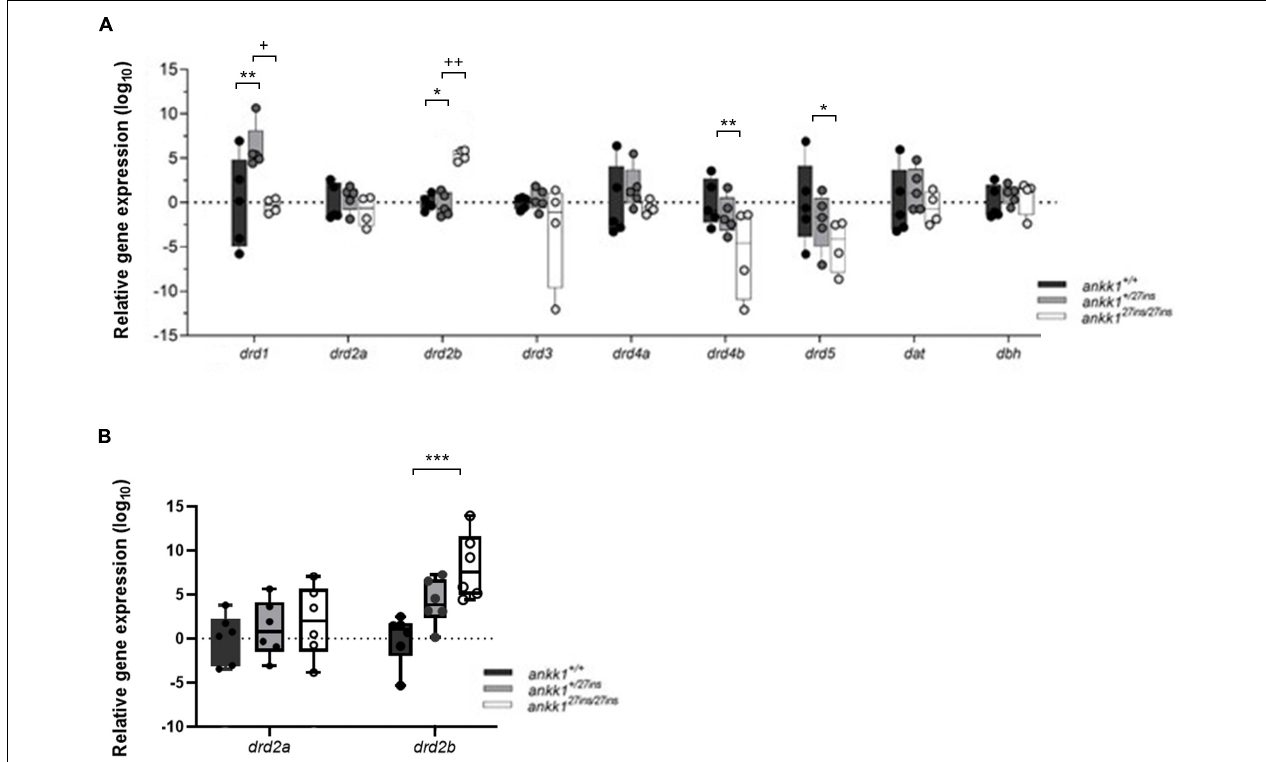
FIGURE 5 | Quantification of dopaminergic gene expression. (A) Expression levels of drd2a , drd2b , drd1 , drd3 , drd4a , drd4b , drd5 , dat , and dbh in 5 days post fertilization zebrafish larvae ( ankk1 + / + , ankk1 + / 27 ins , and ankk1 27 ins / 27 ins ) measured by qPCR. Each dot represents a pool of larvae ( n total = 80 larvae: 5 samples consisting of 16 larvae for ankk1 + / + and ankk1 + / 27 ins , and 4 samples consisting of 16 larvae for each sample (ankk1 27 ins / 27 ins ). (B) Expression levels of drd2a and drd2b in adult zebrafish whole brains. Each dot represents a single brain. Data are shown in box-whiskers plot (5–95 percentile). Legend: * p < 0.05 versus ankk1 + / + ; ** p < 0.01 versus ankk1 + / + ; *** p < 0.0001 versus ankk1 + / + ; + p < 0.05 versus corresponding ankk1 + / 27 ins ; ++ p < 0.01 versus corresponding ankk1 + / 27 ins . Statistics for gene expression data and P value adjustment are provided in Supplementary Tables 2, 3